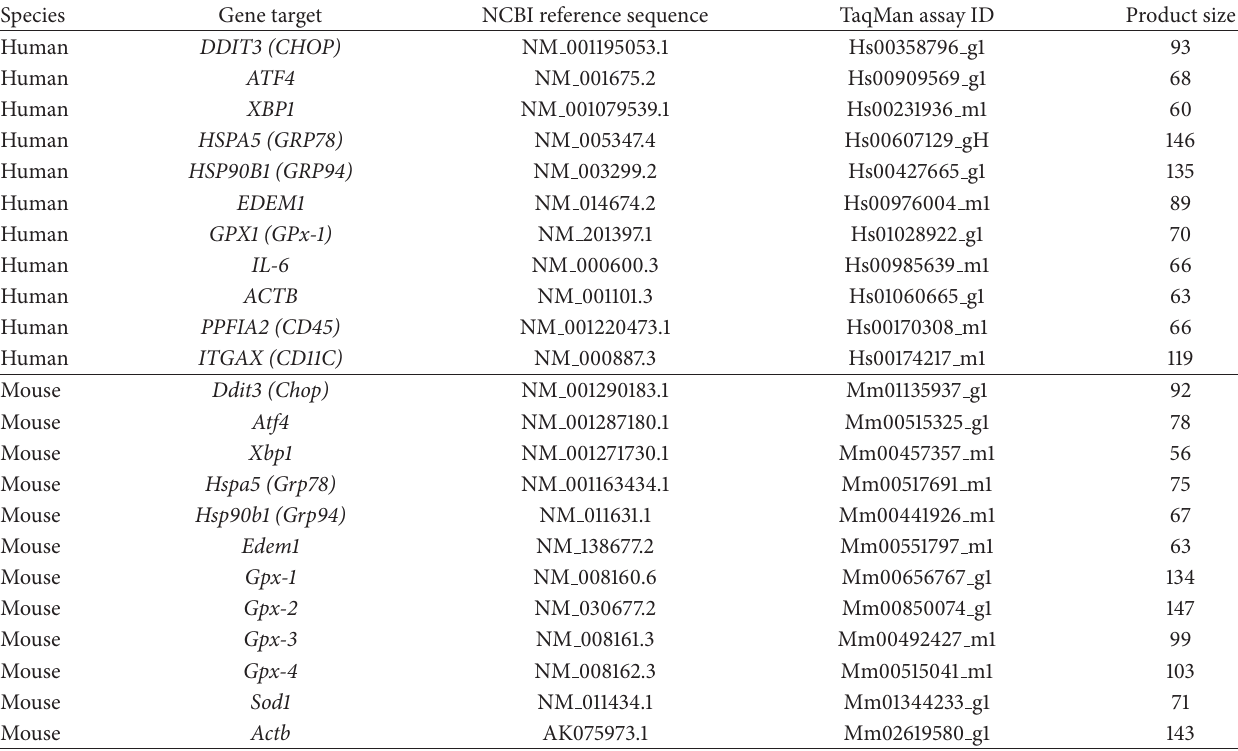
Table 2: TaqMan probe details for gene expression